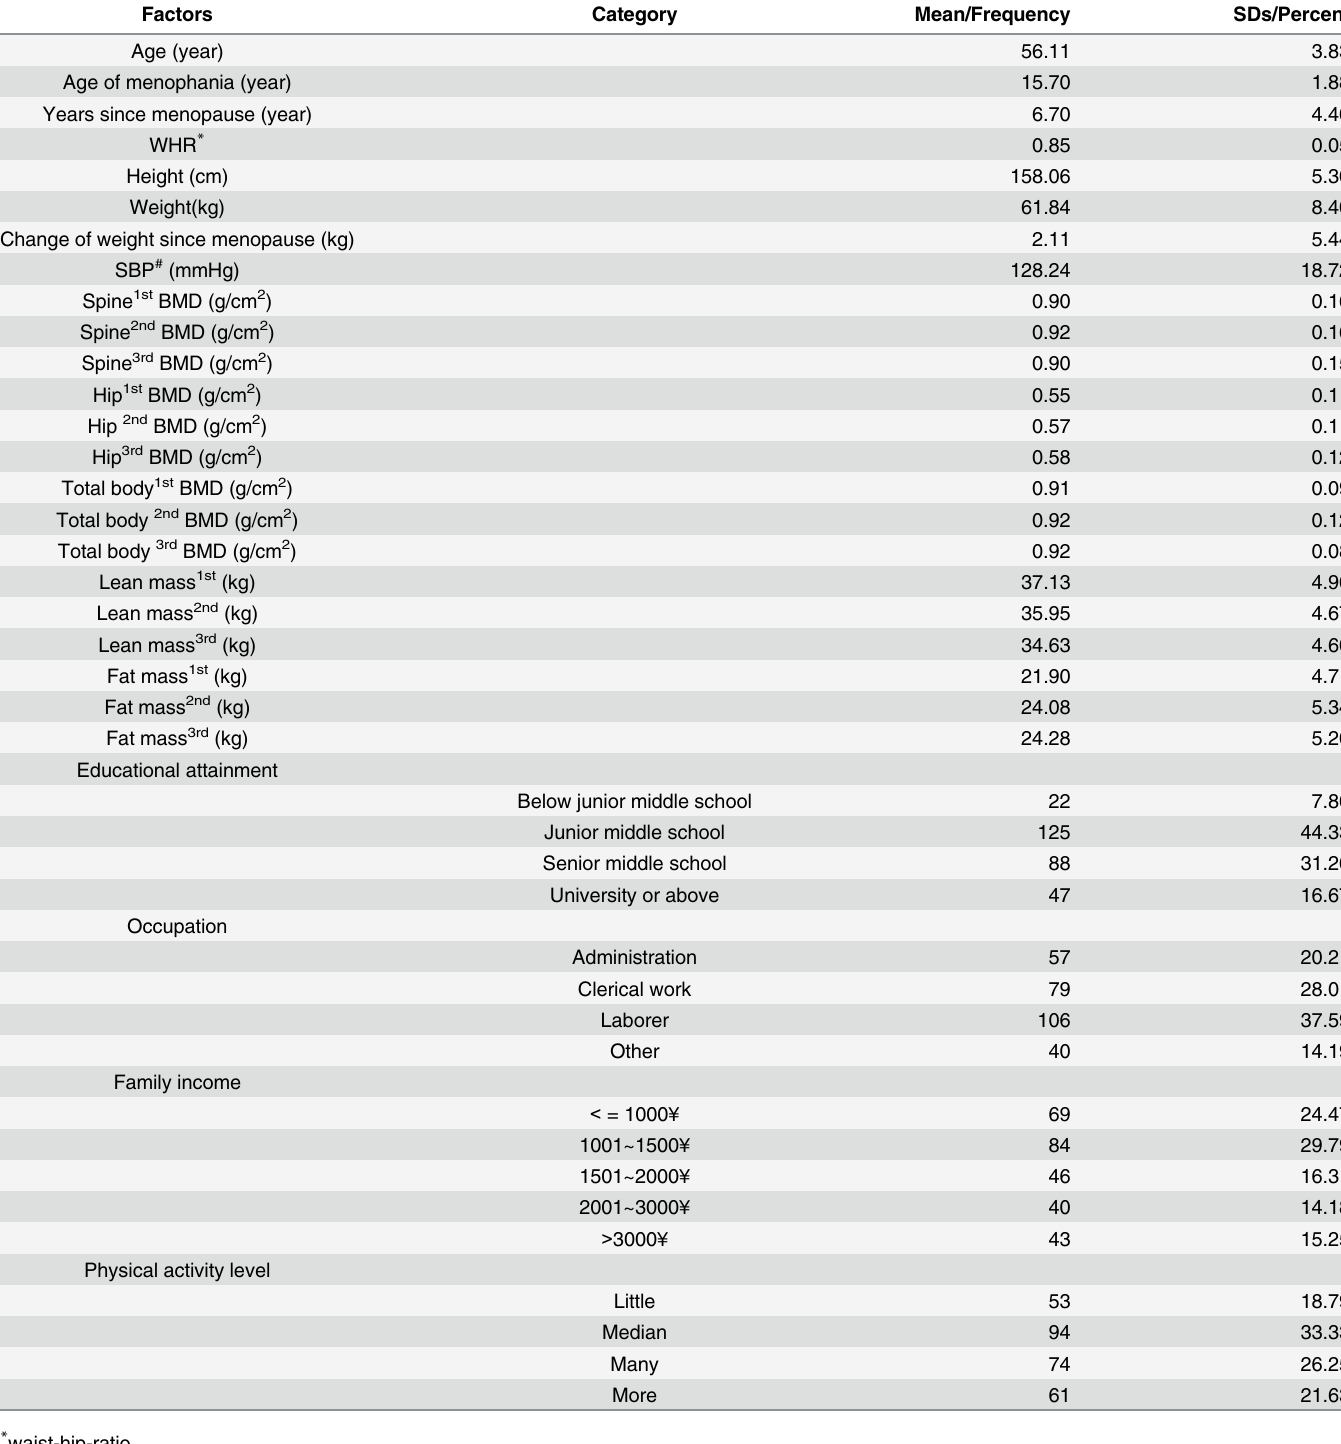
Table 1. The characteristics of participants at baseline and